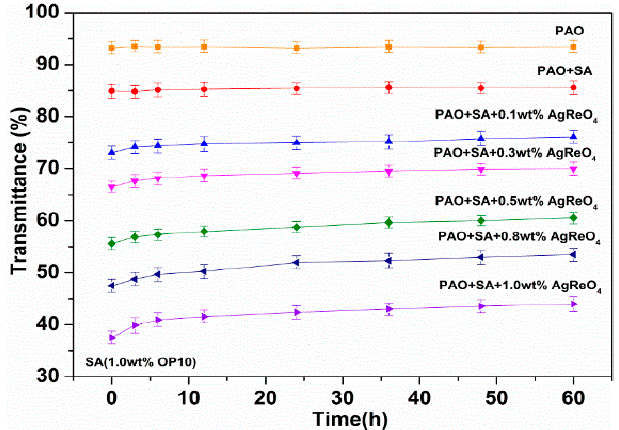
Figure 5. The transmittances of base oil containing various concentrations of AgReO 4 additive with the help of